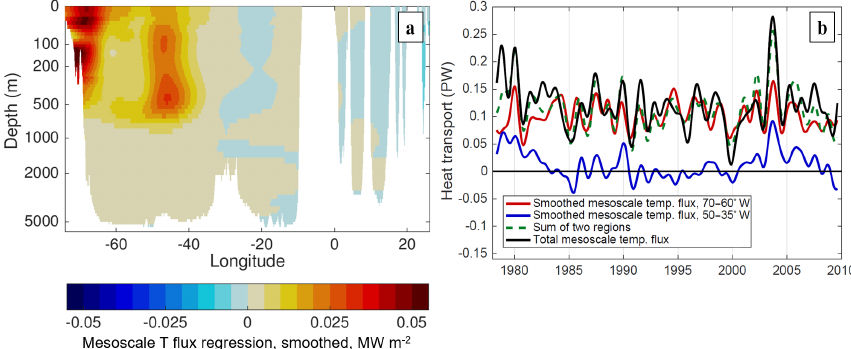
Figure 8. (a) Regression of + 1 σ of the basin-integrated mesoscale temperature flux onto the local zonally smoothed mesoscale temperature flux, indicating the distribution of the temperature flux contributions along the transect. (b) Time series comparison of the zonally smoothed mesoscale temperature flux integrated in two regions (70–60 and 50–35 ◦ W) and the sum of the contributions in these regions with the total basin-integrated mesoscale temperature